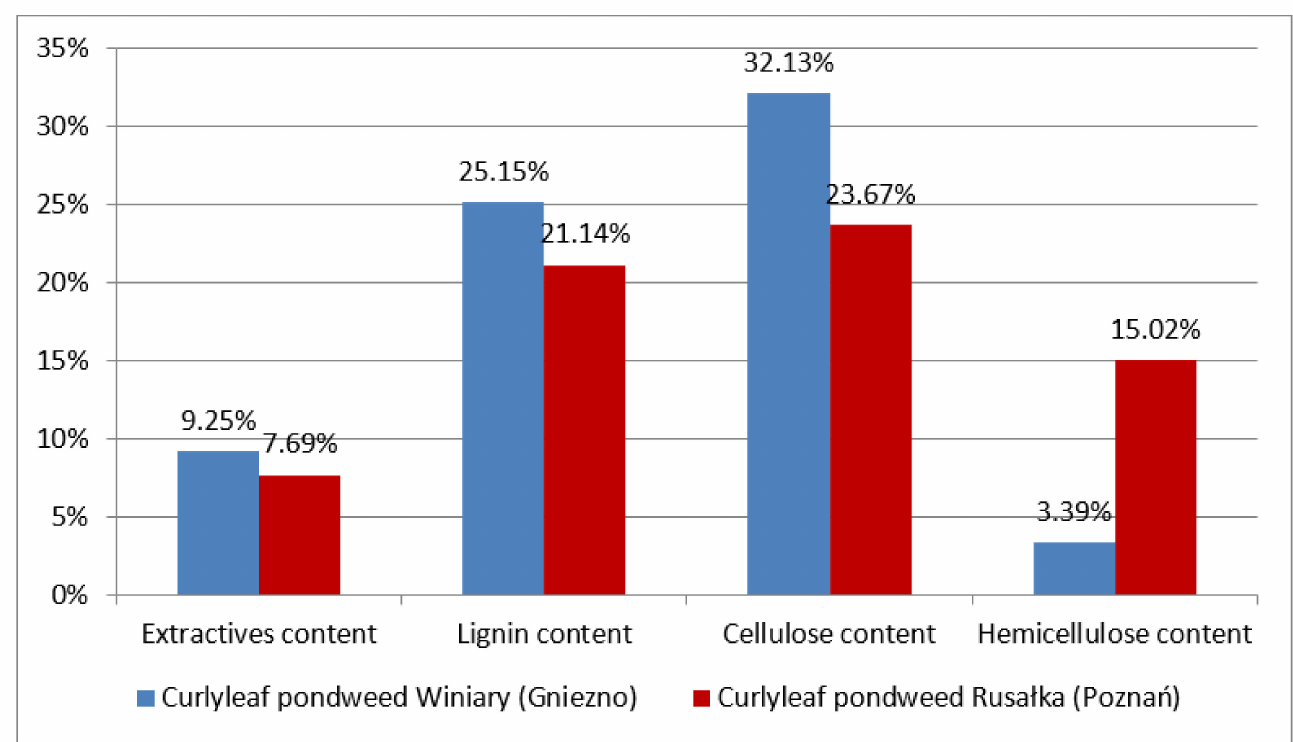
Figure 2. Chemical analysis results for the curly-leaf pondweed samples